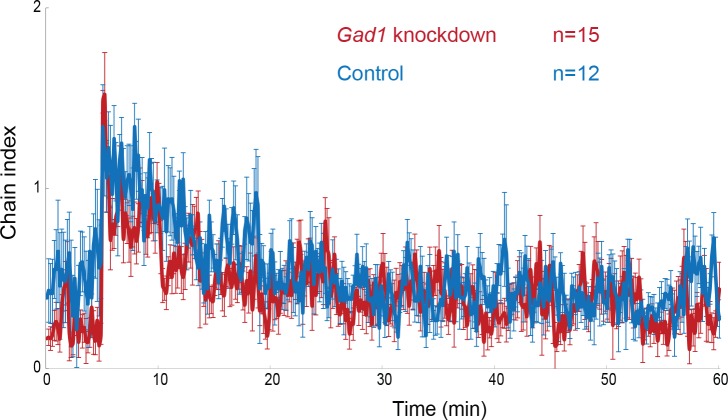
Male Gad1 knockdown flies responded normally to conspecific courtship song.The time-courses of the chain index in response to playback of conspecific song in Gad1 knockdown group (red, Gad1-GAL4/+; UAS-Gad1 RNAi/+) and control group (blue, Gad1-GAL4/+; +/+) are shown. The way to perform chaining test is similar to that described in the Method part. Sound playback starts at 5 min and lasts until 60 min. Error bars denotes s.e.m. n, number of behavioral chambers examined.